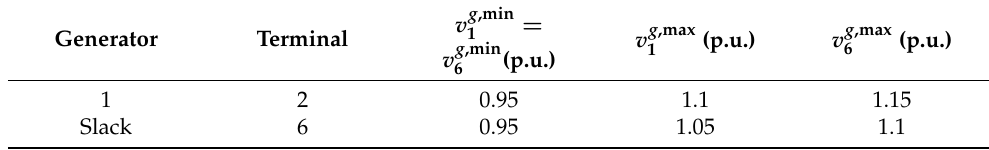
Table 3. Technical characteristics of the generators in the IEEE 6-bus test